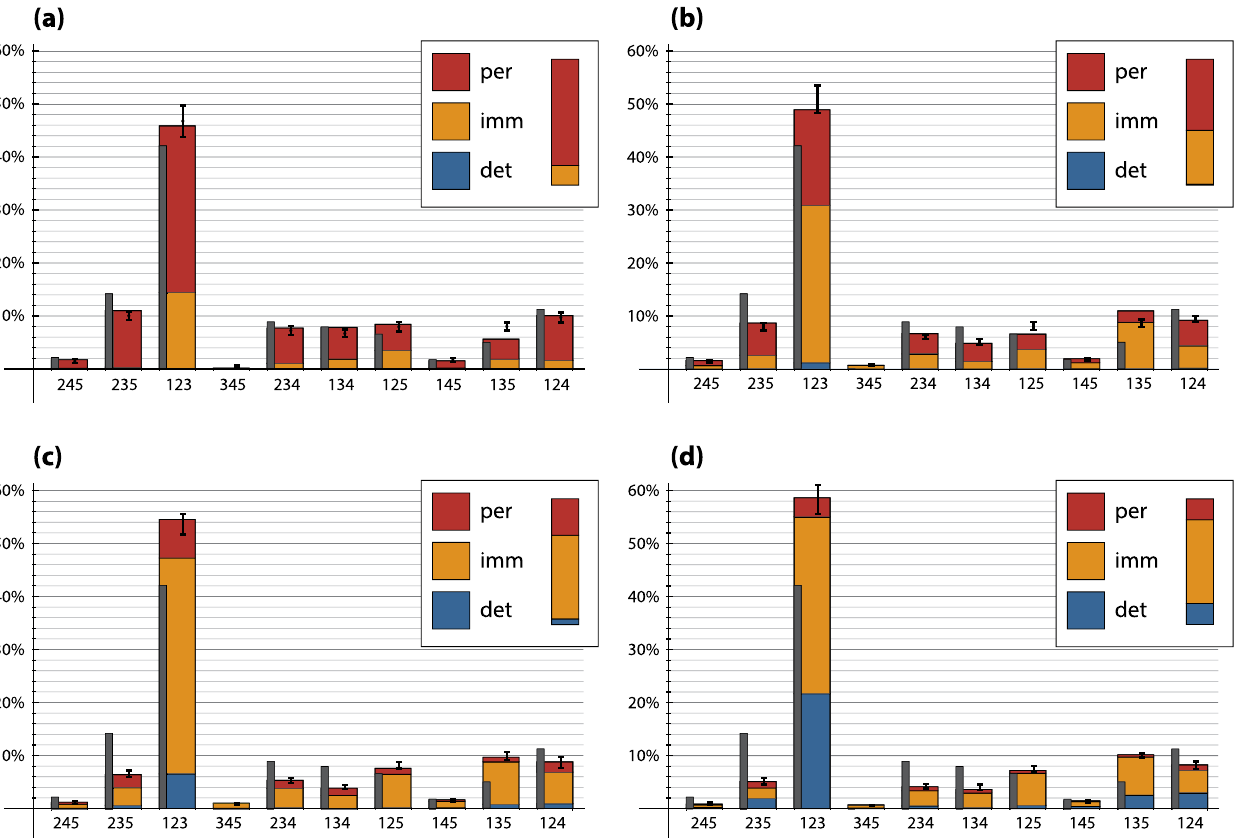
FIG. 4. Experimental output distribution for indistinguishable, semidistinguishable, and distinguishable photons. Various temporal delays for three photons lead to different contributions of permanents, immanants, and determinants. The normalized output probability distributions for the three photons is measured as coincidences from different spatial modes, resulting in ten elements. For all temporal delays the three photons exhibit slight spectral mismatch. Panel (a) depicts the case for a small temporal offset Δ τ 1 ≪ τ Fig. 3), whereas for (b) and (c) this delay is increased along a diagonal axis Δ τ 1 ≈ Δ τ 2 ( P 3 and P 4 of Fig. 3). The extreme case of complete distinguishability and therefore classical behavior is shown in (d) ( P 6 of Fig. 3). As a reference, the gray bars illustrate the case for perfect indistinguishability and therefore only contribution from the permanent of the scattering submatrix. The interferometer independent contribution F , F , and F is shown in the figure legend. The error bars of the experimental data are standard per det imm deviations over 19 independent